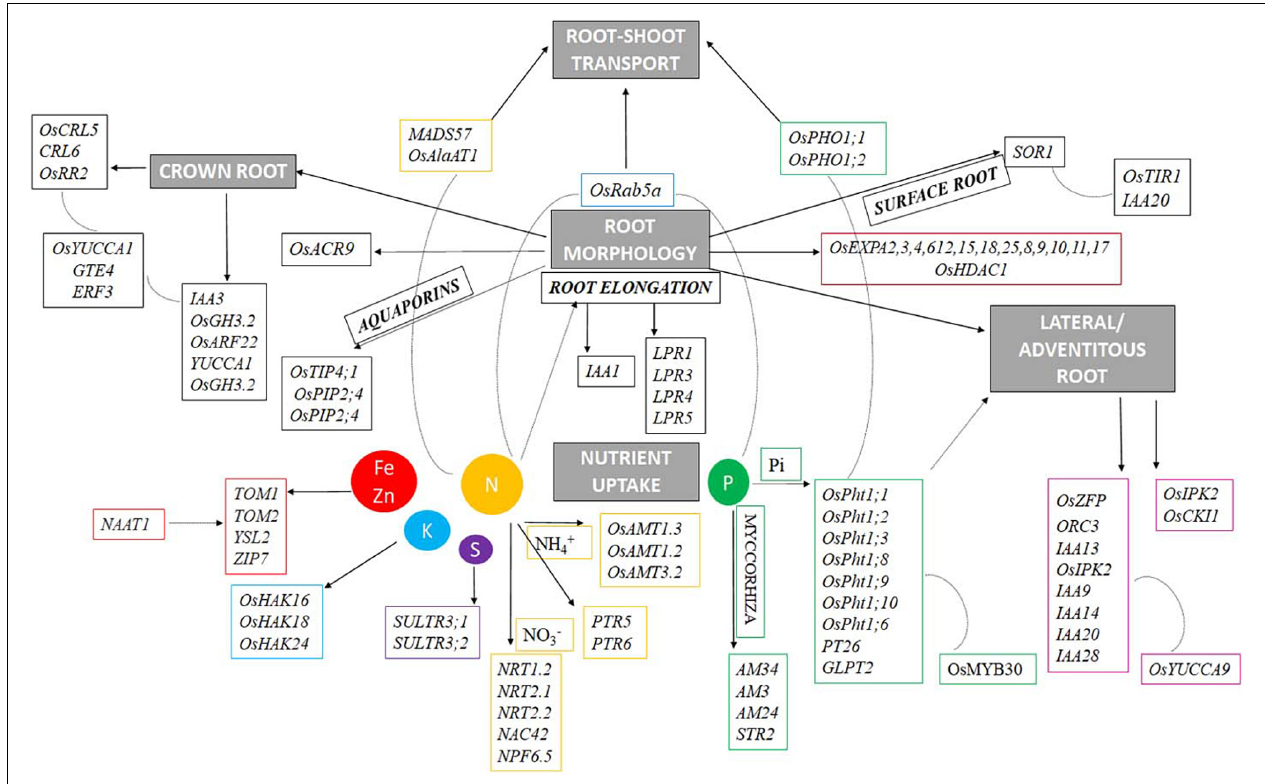
FIGURE 11 | Proposed regulatory network mechanism involved in root architecture and nutrient acquisition for early root vigor in rice under DSR conditions.